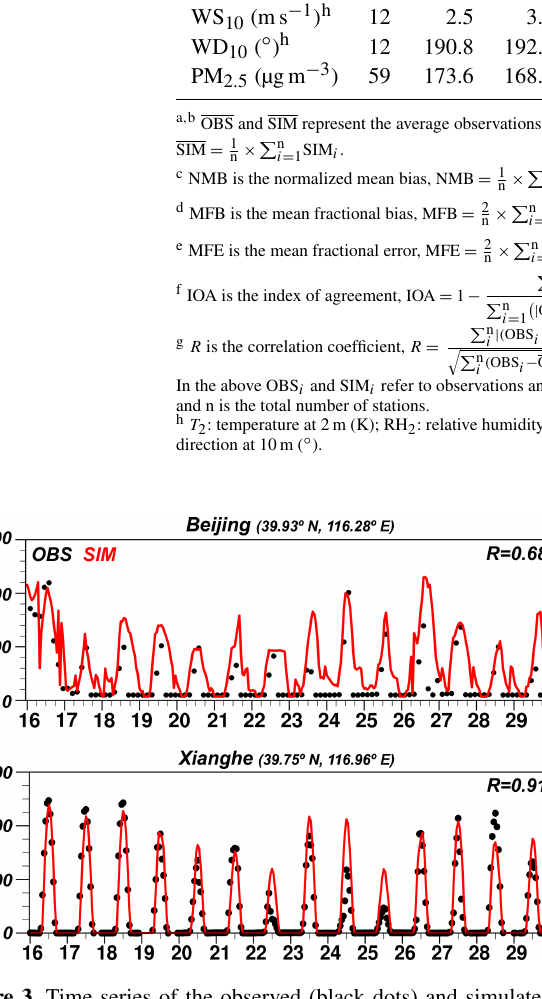
Figure 3. Time series of the observed (black dots) and simulated (red lines) hourly planetary boundary layer height (PBLH, m) at the site in Beijing (39.93 ◦ N, 116.28 ◦ E), and shortwave downward ra- diation flux (SWDOWN, Wm − 2 ) at the Xianghe station (39.75 ◦ N, 116.96 ◦ E) from 16 to 29 December 2015. Notably, PBLH mea- surements provided by Global Data Assimilation System (GDAS) are in 3h intervals. All times are converted to China standard time (Beijing